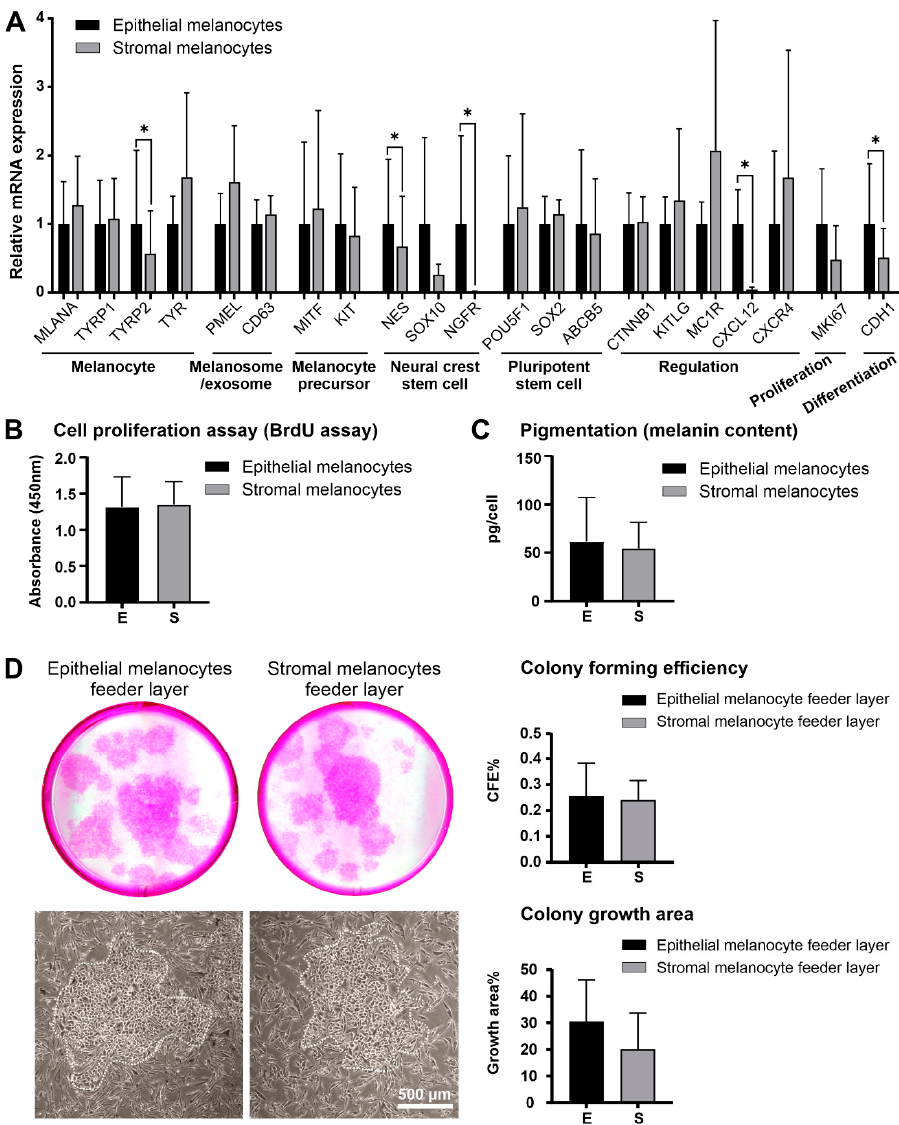
Figure 4. Comparative analysis of limbal epithelial and stromal melanocytes. ( A ). Quantitative real-time polymerase chain reaction (qRT-PCR) primer assays showing relative expression levels of